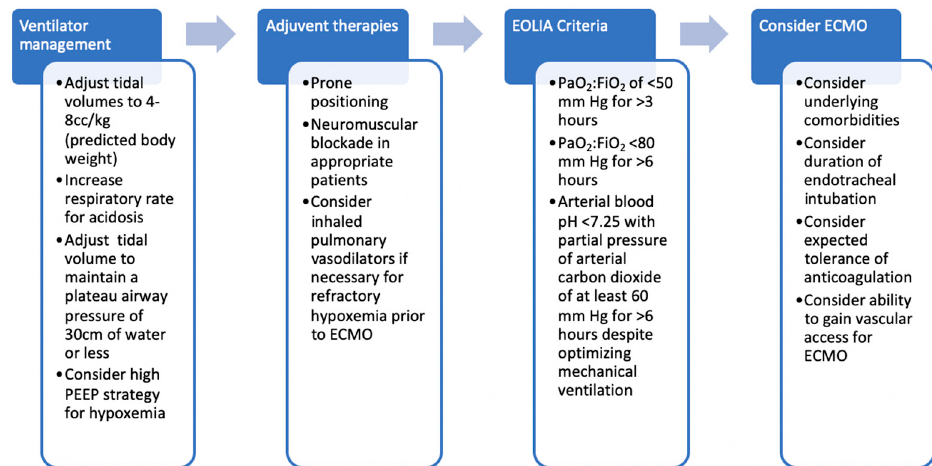
Figure 1. Algorithm for determination of candidacy for ECMO for ARDS. ECMO is appropriate EOLIA criteria despite optimal ventilator management and adjuvant therapies. Abbreviations: ECMO, extracorporeal for patients meeting EOLIA criteria despite optimal ventilator management and adjuvant thera- membrane oxygenation; FiO 2 , fraction of inspired oxygen; PaO 2 , partial pressure of arterial oxygen; PEEP, positive pies. Abbreviations: ECMO, extracorporeal membrane oxygenation; FiO 2 , fraction of inspired oxy- end-expiratory gen; PaO 2 , partial pressure of arterial oxygen; PEEP, positive end-expiratory pressure.